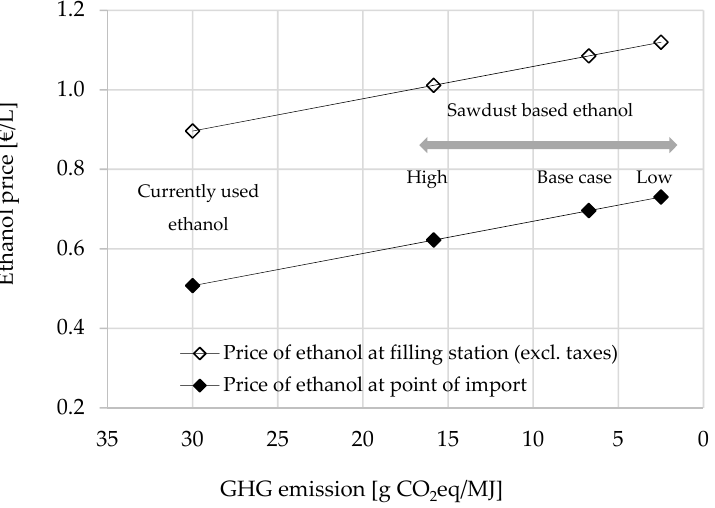
Figure 3. The relation between GHG emission and GHG-adjusted ethanol price in the Swedish reduction obligation system based on current fuel prices (2018), and assuming the same average GHG emission as for fuel ethanol used in Sweden in 2018.